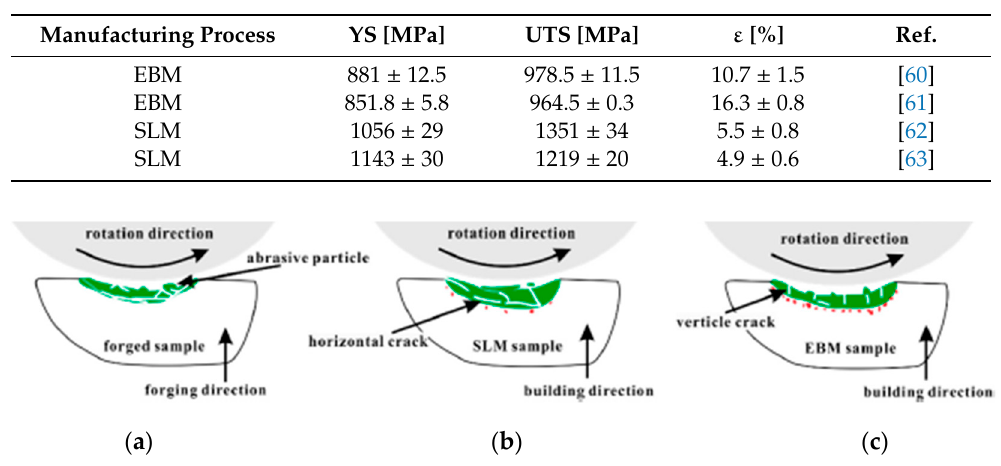
Figure 9. Wear mechanisms in the Ti–6Al–4V samples built by ( a ) forging, ( b ) SLM, and ( c ) EBM. Reproduced from [59], under CC BY 4.0. Table 1. Mechanical properties of as-built Ti–6Al–4V specimens in tensile testing. UTS: ultimate tensile strength, YS: yield strength.